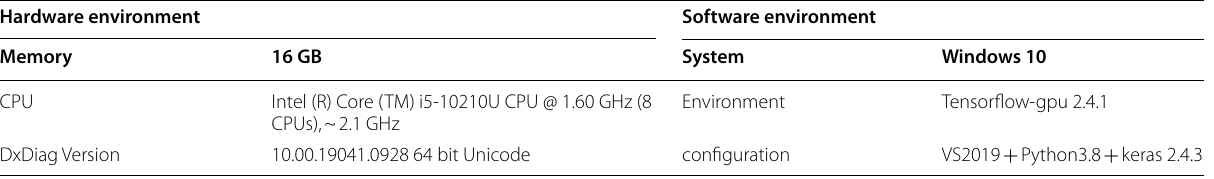
Table 1 Experimental environment Hardware